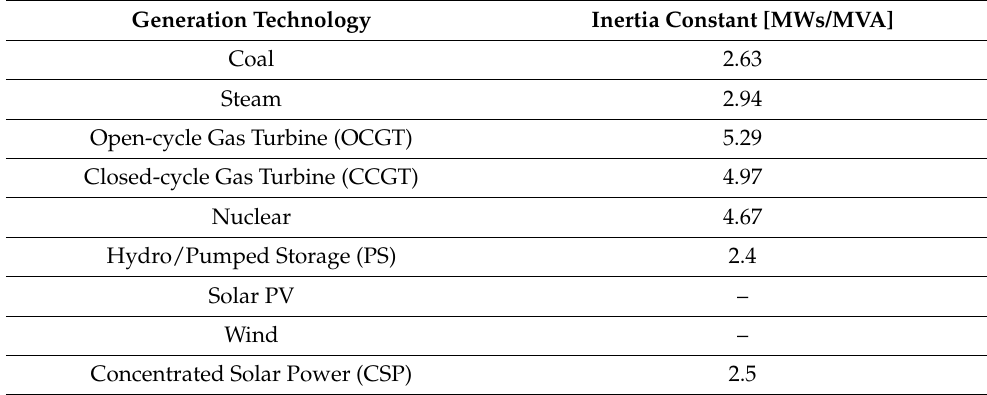
Table 4. Typical values of H for different generation technologies at 3600 rpm [33,34].